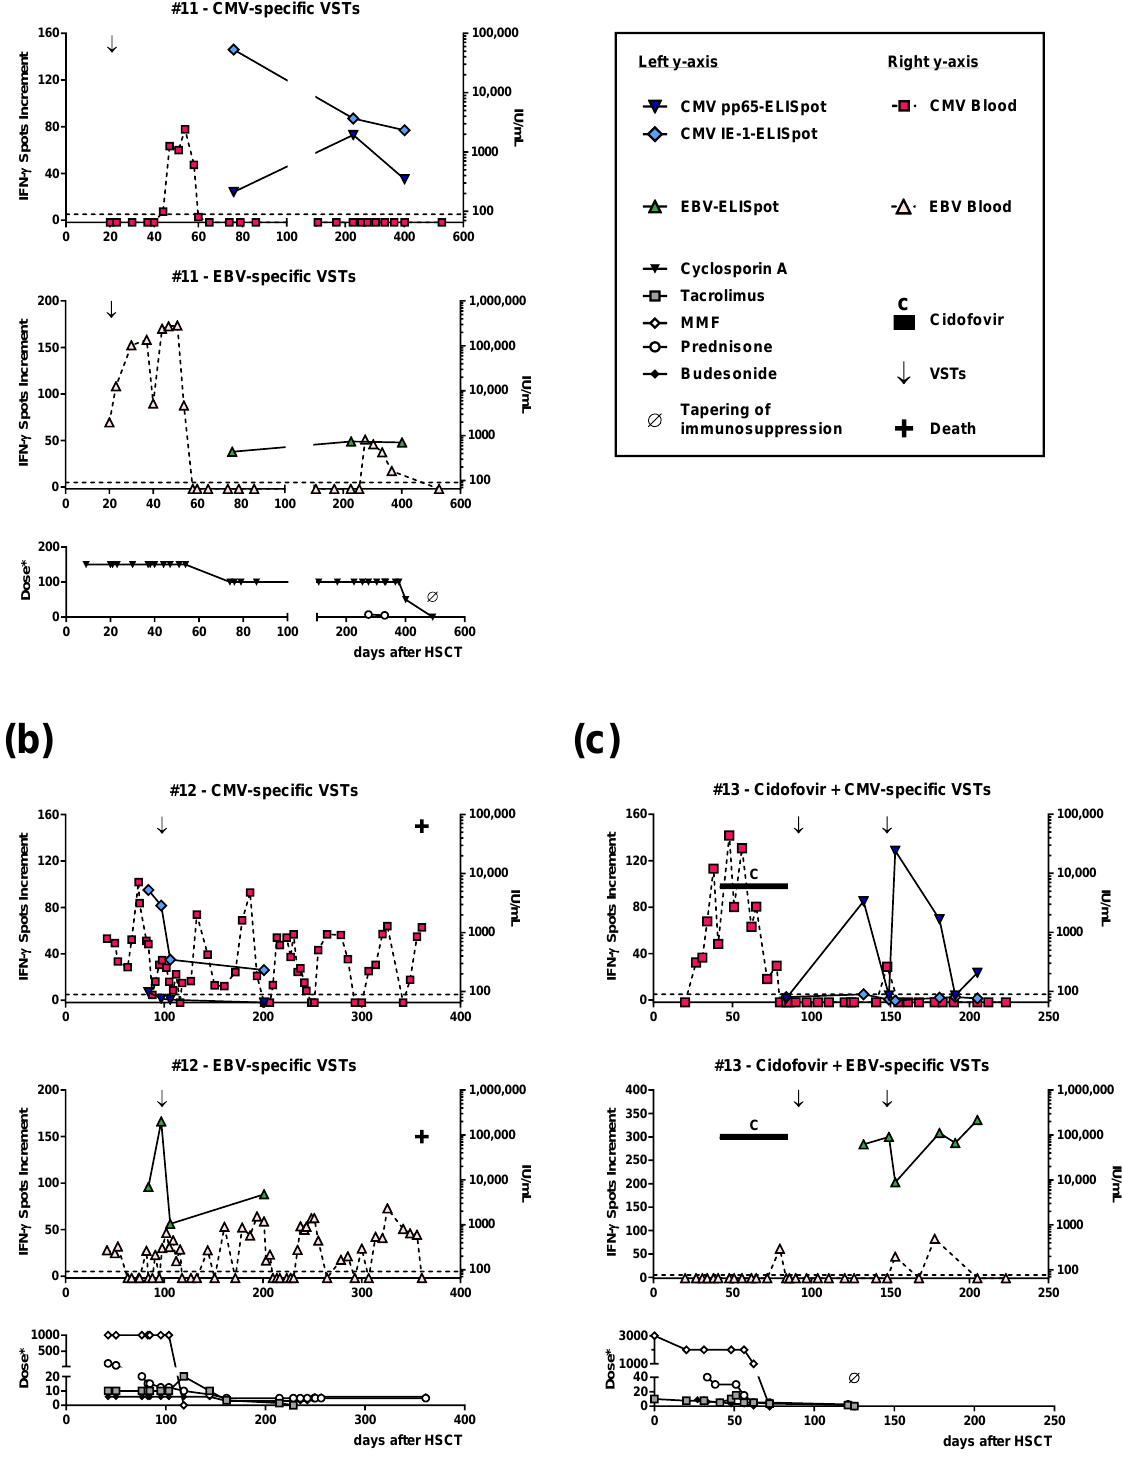
Figure 2. Follow-up data of hematopoietic stem cell transplant (HSCT) recipients who received tri-specific virus-specific T cells (VSTs), directed against BK virus, cytomegalovirus (CMV), and Ep- stein–Barr virus (EBV). The graphs show cellular in vitro responses against CMV phosphoprotein 65 (pp65) and immediate early-1 (IE-1) and EBV and viral load of CMV and EBV. Panel ( a )